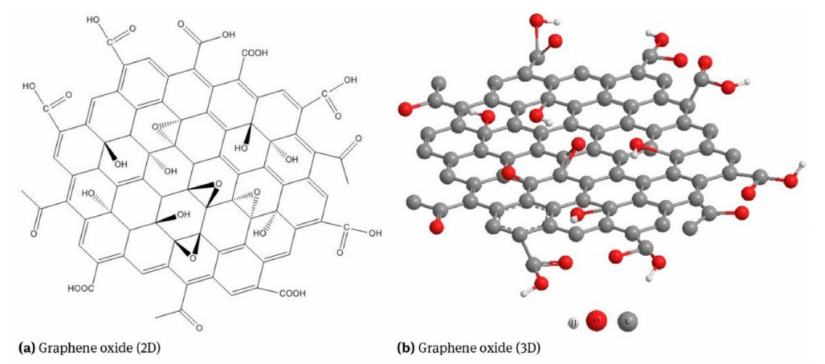
Figure 2. Graphene oxide